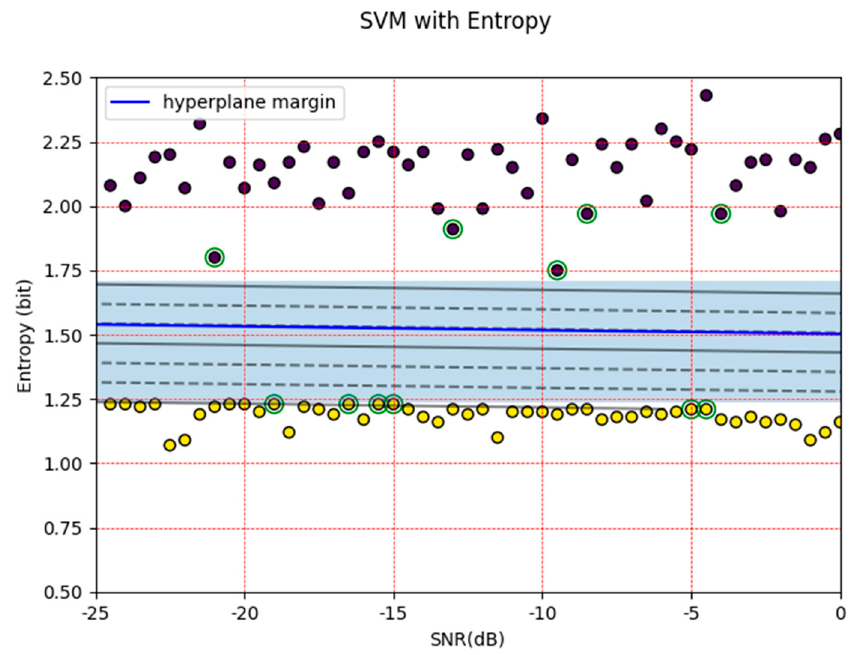
Figure 8. SVM with entropy with the GSMK signal. Electronics 2020 , 9 , x FOR PEER REVIEW